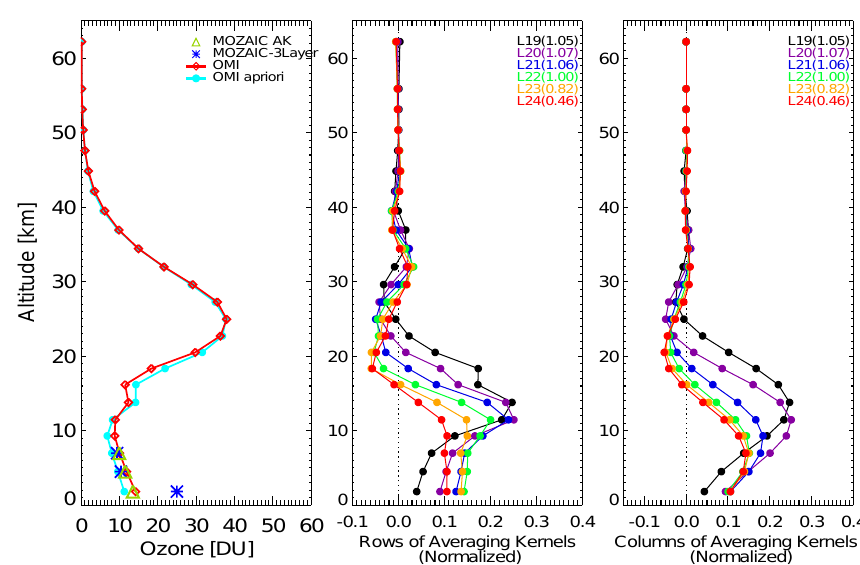
Figure 4. Ozone profile and AKs used for comparison for 22 June 2005. Latitude and longitude correspond to the OMI grid corresponding to the MOZAIC measurements. (Left) Solid blue line indicates the OMI a priori ozone profile; solid red line indicates the ozone profile derived from OMI spectra. Blue asterisks indicate MOZAIC ozone values adjusted to corresponding OMI layers. Light green triangles indicate MOZAIC ozone values convolved with the AKs shown in the middle panel. (Middle) Profiles of the rows of AKs normalized by the a priori error for the six layers of OMI retrieval. Black, violet, blue, green, yellow, and red lines correspond to the 19th, 20th, 21st, 22nd, 23rd, and 24th layers, respectively. The total retrieval efficiencies are shown in parentheses. (Right) Same as the middle panel but for the columns of the AKs normalized by the a priori